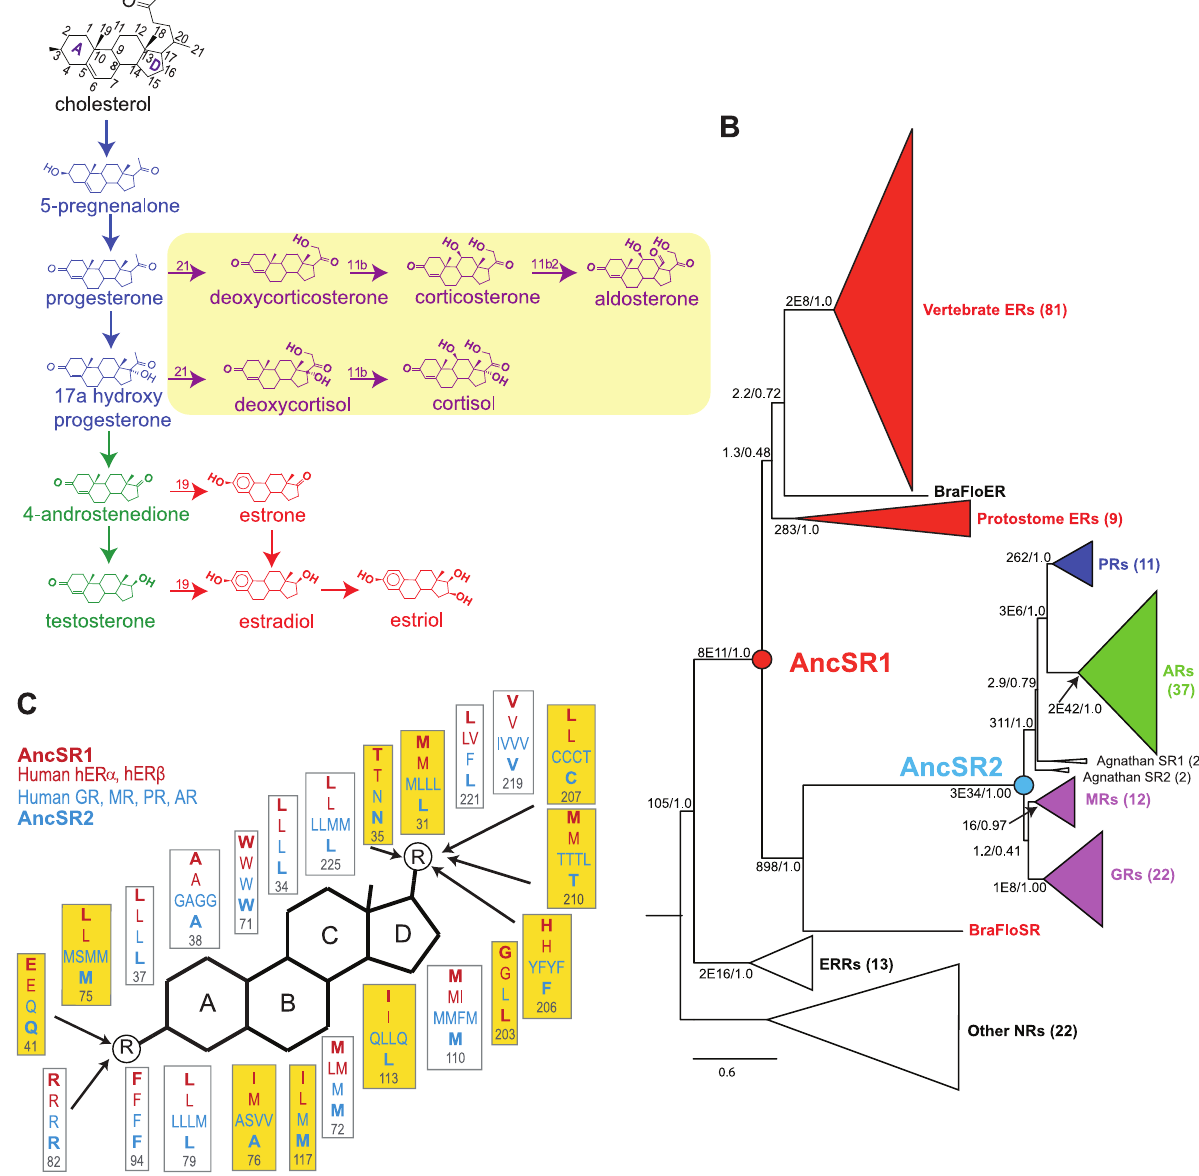
Figure 1. Evolutionary expansion of the steroid receptors and their ligands. A, Pathway for synthesis of vertebrate steroid hormones. The main pathway – synthesis of estrogens (red) via progestagens (blue) and androgens (green) – is at least as ancient as the chordate ancestor. Yellow box, synthesis pathway to corticosteroids (purple), is a later evolutionary novelty found only in vertebrates. The numbering system on the steroid backbone is shown in black. B, Phylogeny of the SR gene family. Receptors are color-coded by the classes of ligands to which they are most sensitive. Ancestral steroid receptors (AncSR1 and AncSR2) resurrected in this study are marked as circles. The number of sequences in each clade is shown in parentheses. Branch supports show approximate likelihood ratios and chi-square confidence metrics for each clade compared to the best phylogeny without that clade. Estrogen-responsive receptors are shown in red. For unreduced phylogenies and a list of sequences, see Figures S10, S11 and Table S7. C, Maximum likelihood reconstruction of ligand-contacting amino acids in AncSR1 and AncSR2, along with residues at homologous sites in extant human SRs. The steroid rings are labeled; circled R indicates polar functional groups at which the major steroid classes differ from each other; arrows indicate residues within hydrogen bonding distance. Residues that differ between AncSR1 and AncSR2 are highlighted in